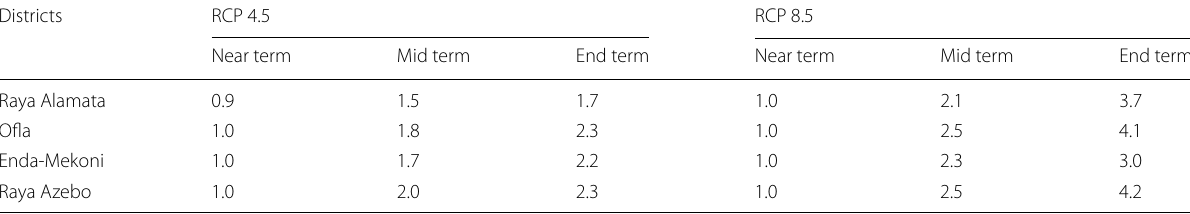
Table 2 Changes in Temperature minimum (°C) compared to the baseline over the four districts in RCP 4.5 and RCP 8.5 Districts